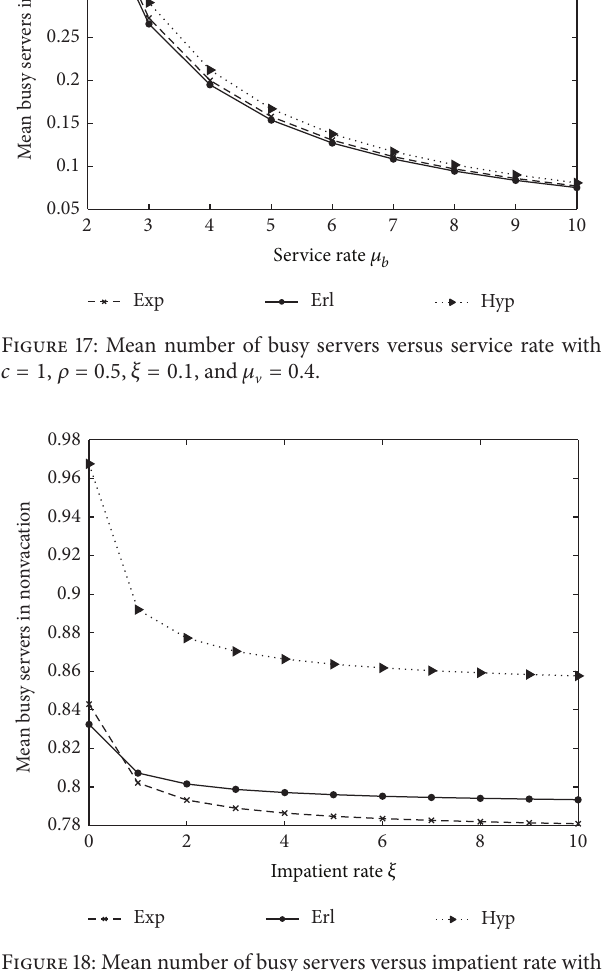
Figure 20: Mean customer loss versus impatient rate with 𝑐 = 3 , = 0.4 , and 𝜃 = 1 𝜌 = 0.5 , 𝜇 V